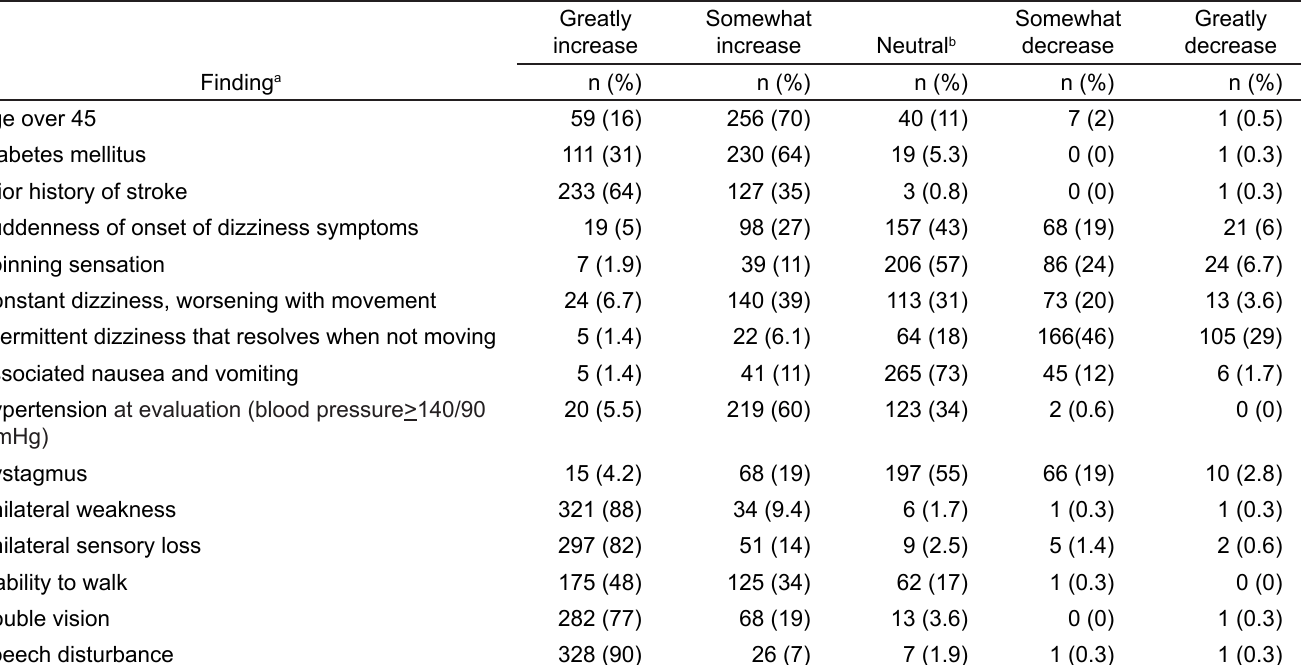
Table 2. Impact of various historical and exam factors on the suspicion for stroke as cause of dizziness in the emergency department. Greatly Finding a